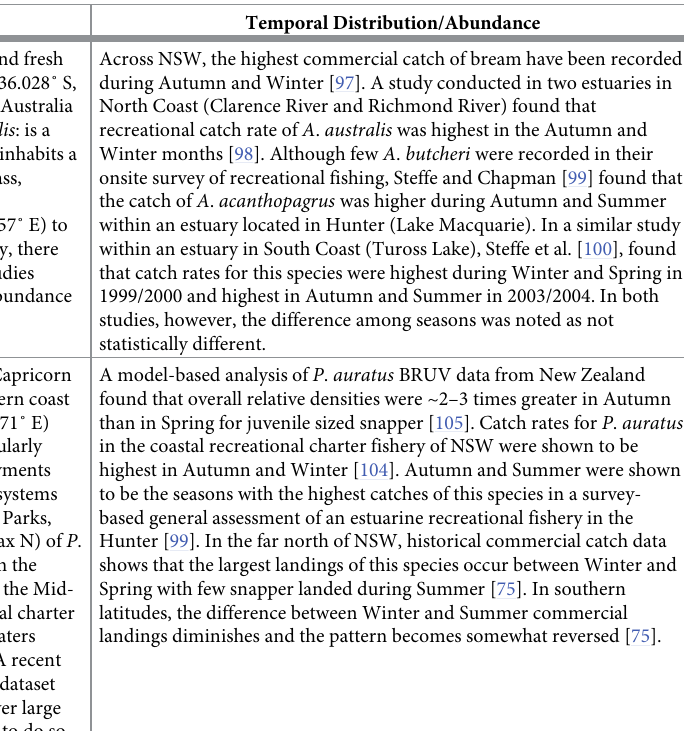
Table 4. Findings on the spatial and temporal patterns of distribution and/or abundance as described in reviewed literature for the bream species complex, snapper, and dusky flathead. Species/taxon Spatial